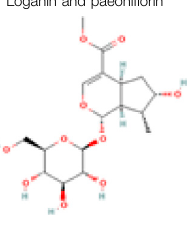
↓ IgG deposition at the dermo- epidermal junction, titers of anti- DNA antibodies and rheumatoid factor, and